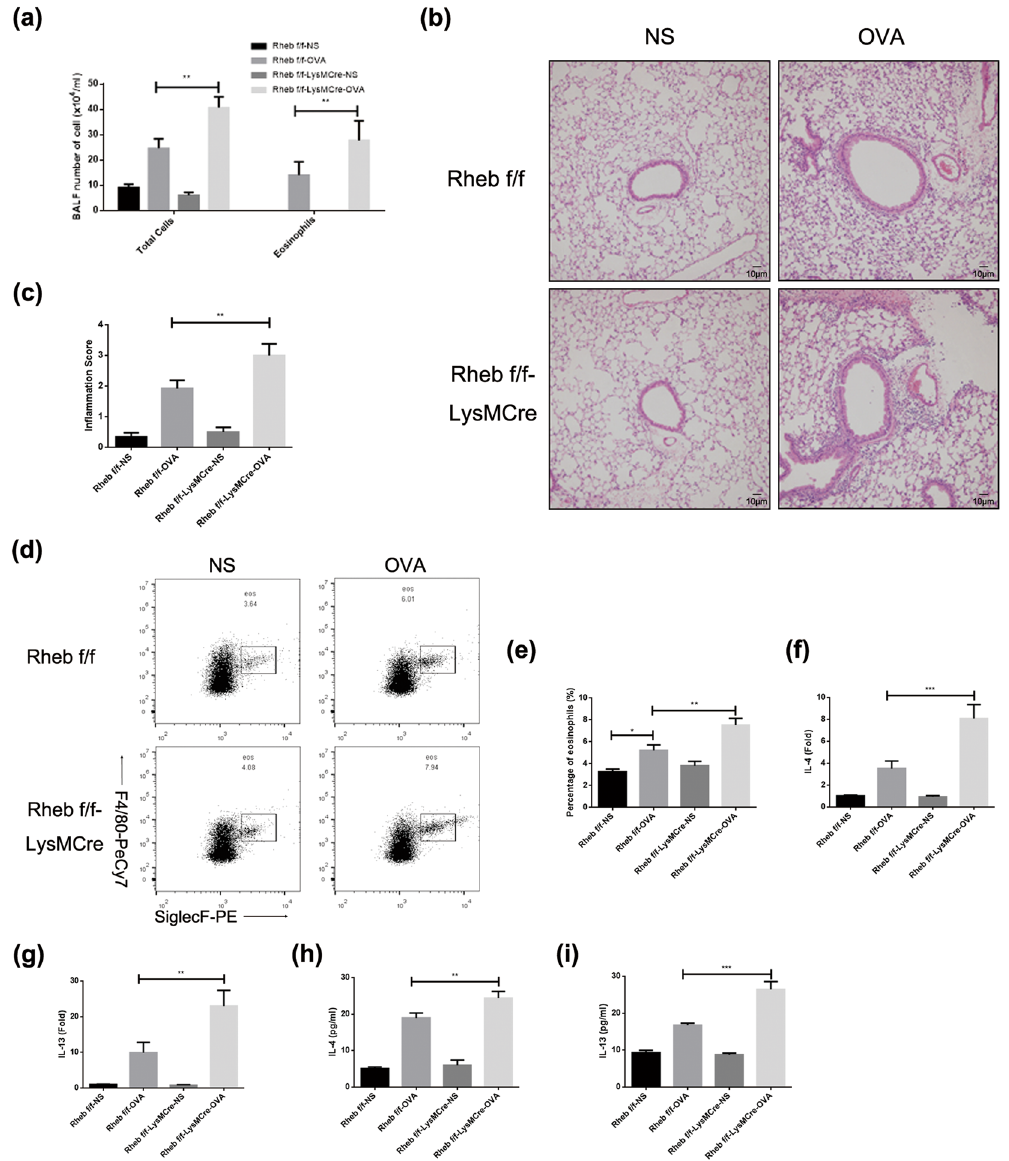
Figure 7. Myeloid knockout of Rheb deteriorates OVA-induced allergic airway inflammation. ( a ) OVA- induced allergic airway inflammation was established using two strains of mice as above. BALFs were obtained and total cells and eosinophils in BALFs were counted. ( b and c ) Representative histological images are shown (b). Inflammation scores were calculated according to H&E slides. ( d and e ) Bone marrow cells were also harvested and red blood cell lysis was performed. Eosinophil percentage was detected (d) and statistically analysed (e). ( f – i ) Th2 cytokines were detected by lung homogenates. f, mRNA expression of IL-4. g, mRNA expression of IL-13. h, protein concentration of IL-4. i, protein concentration of IL-13. Results were analysed as means ± SEM. All the results above were repeated by three independent experiments (n = 8 per group). * P < 0.05, ** P < 0.01, *** P <